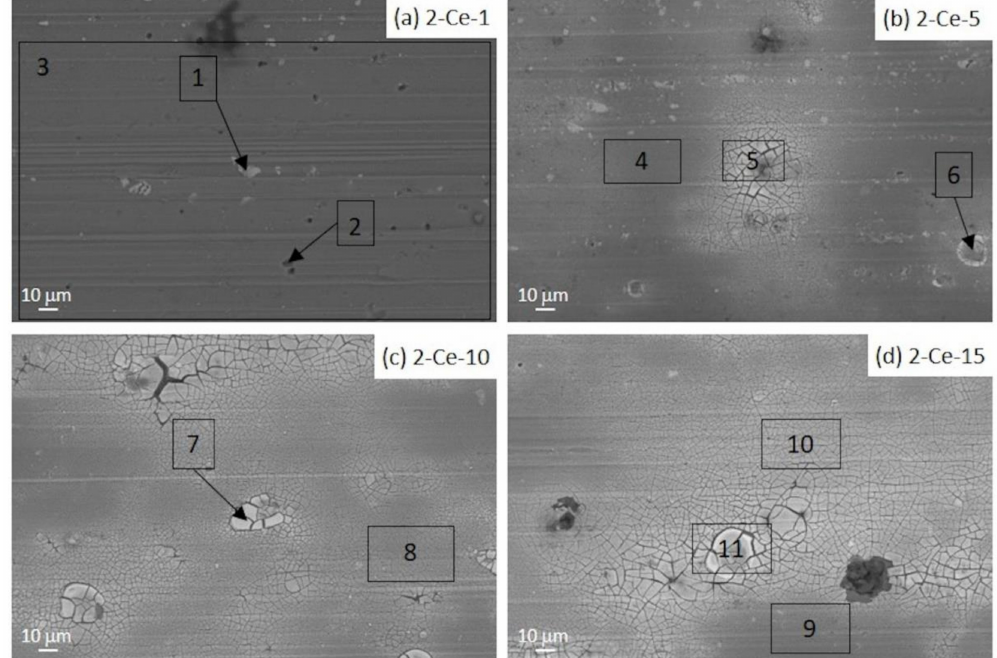
Figure 1. SEM images of 2024 samples: ( a ) 2-Ce-1, ( b ) 2-Ce-5, ( c ) 2-Ce-10, and ( d ) 2-Ce-15. EDX analyses were acquired in the points (arrows) or areas (square)